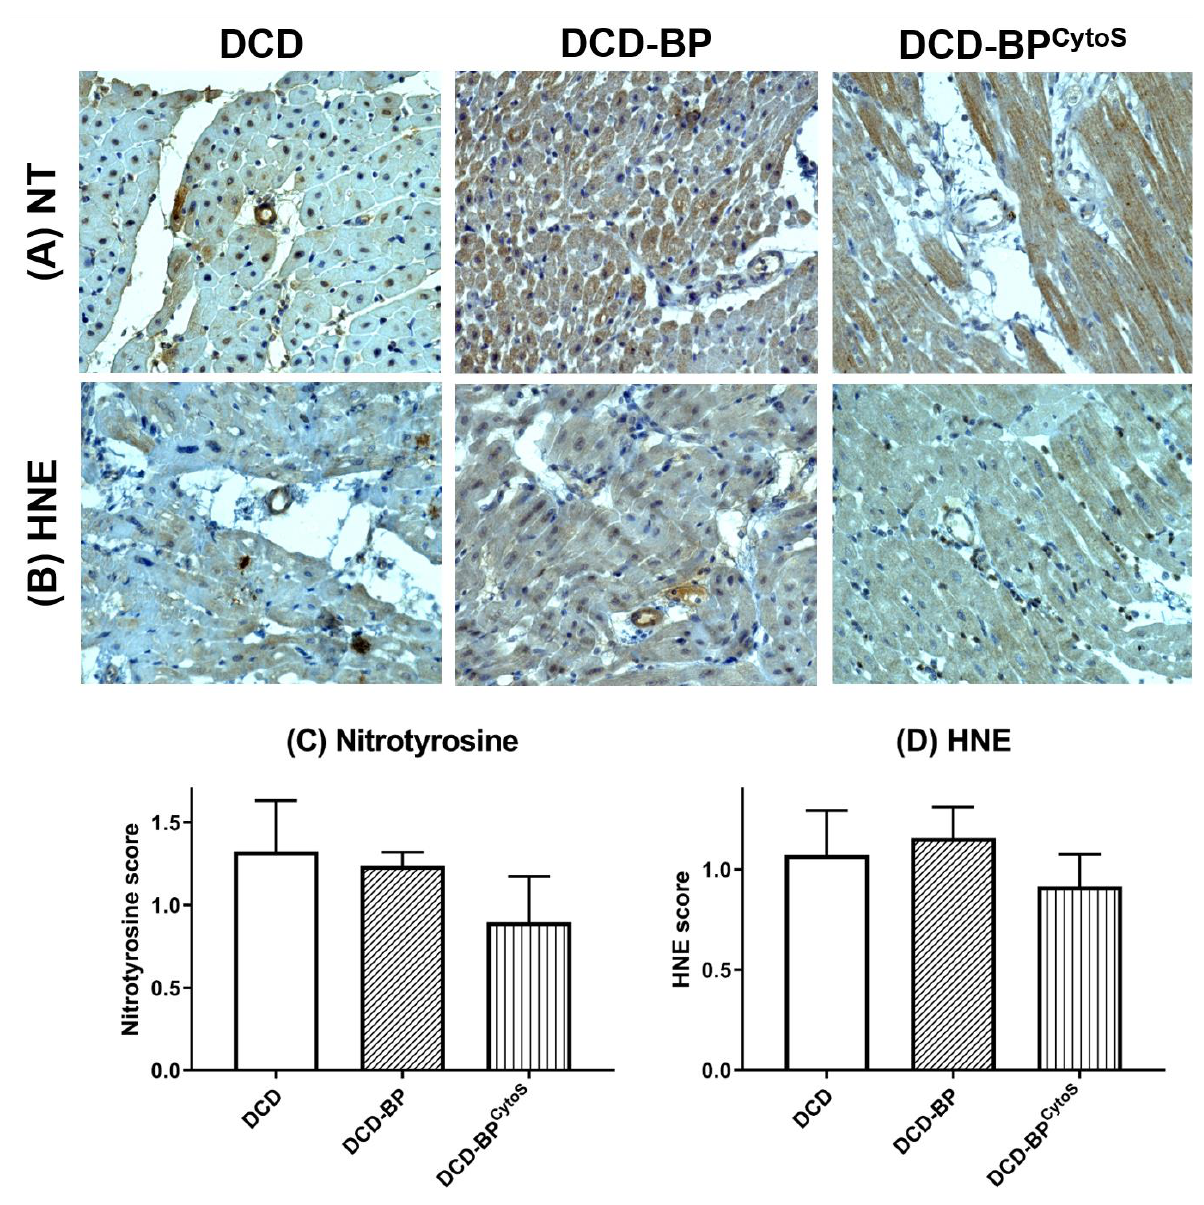
Figure 5. Representative photomicrographs of immunohistochemical staining of endothelial oxidative stress ( A , B ). Semiquantitative analysis of arteriolar immunoreactivity ( C , D ). BP: blood perfusion. CD: cluster of differentiation. DCD: donation after circulatory death. BP CytoS : blood perfusion with an integrated cytokine adsorption device. NT: nitrotyrosine. HNE: hydrxynonenal.